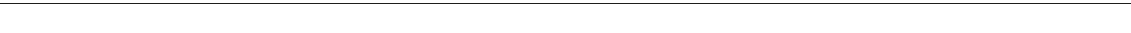
Fig. 5 Accumulation of immunostimulatory 5 ′ -ppp-vtRNAs during lytic reactivation. a Predicted secondary structure of vtRNAs generated by RNAfold. b SYBR-Gold staining of in vitro transcribed vtRNAs with or without CIP treatment. c HCT116 ISG54-luciferase reporter cells were transfected with 100 ng in vitro transcribed vtRNAs with or without CIP treatment. Cells were harvested 24 h posttransfection and subjected to luciferase assay. Mock indicated cells without RNA transfection and was set as 1. d BC-3 cells were reactivated for 3 days and expression of DUSP11 was quanti fi ed by RT-qPCR. L latency, D1 – D3 lytic reactivation for 1 day to 3 days. The DUSP11 expression was normalized to the level of 18S rRNA and L was set as 1. e Cell lysates were prepared from BC-3 cells described in ( d ) and DUSP11 protein levels were monitored by Western blot. GAPDH was run as a loading control. f Latent and lytic BC-3 cells were subjected to RNAP II ChIP-qPCR analysis. Signals were normalized to input. g Total RNA, extracted from latent or 72 h postreactivation BC-3 cells, was subjected to splint-ligation to quantify 5 ′ -monophosphorylated vtRNAs. * denotes a product of adapter-adapter ligation (see Supplementary Fig. 7). h HCT116 ISG54-luciferase reporter cells were transfected with vtRNA or U1 RNA isolated by antisense oligonucleotide af fi nity selection from either latent or lytic BC-3 cells. Cells were harvested 12 h posttransfection and subjected to luciferase assay. Mock indicated cells without RNA transfection and was set as 1. Error bars in all panels represent mean ± SD from three independent experiments. p Values were determined by the Student ’ s t test, * p < 0.05, ** p <